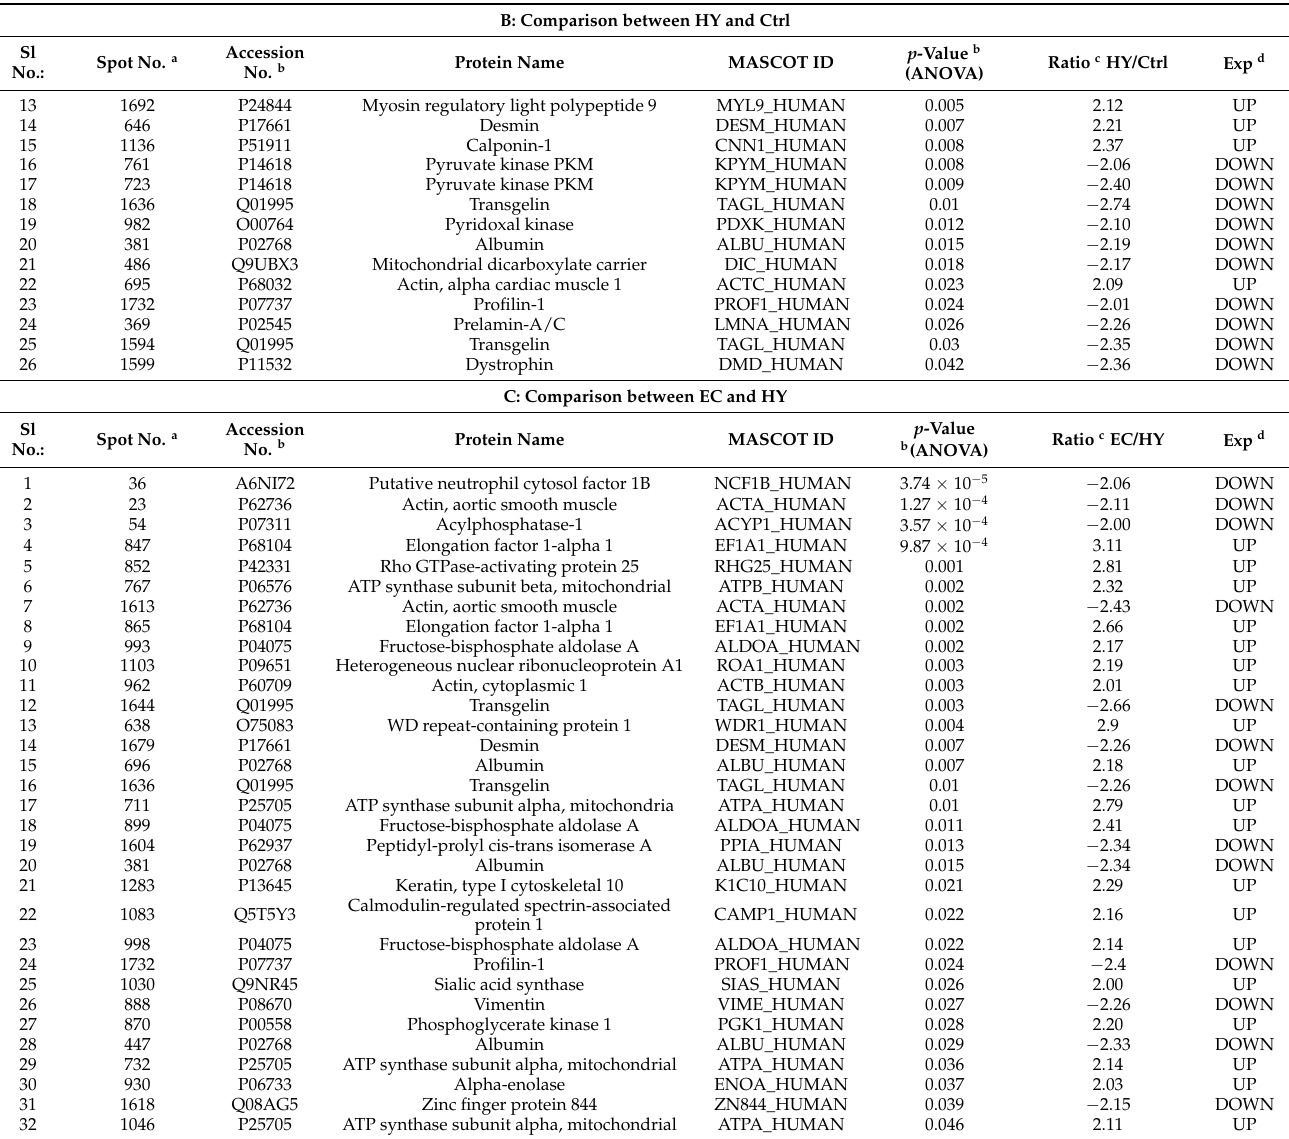
Table 1. Cont. B: Comparison between HY and Ctrl